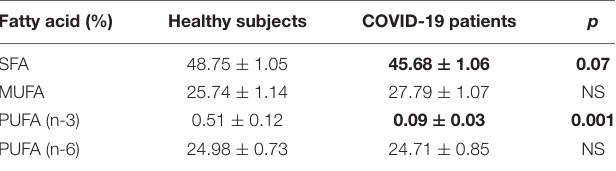
TABLE 10 | Fatty acid compositions of the NEFAs; saturated, monounsaturated, and polyunsaturated in the plasma from the healthy subjects and COVID-19